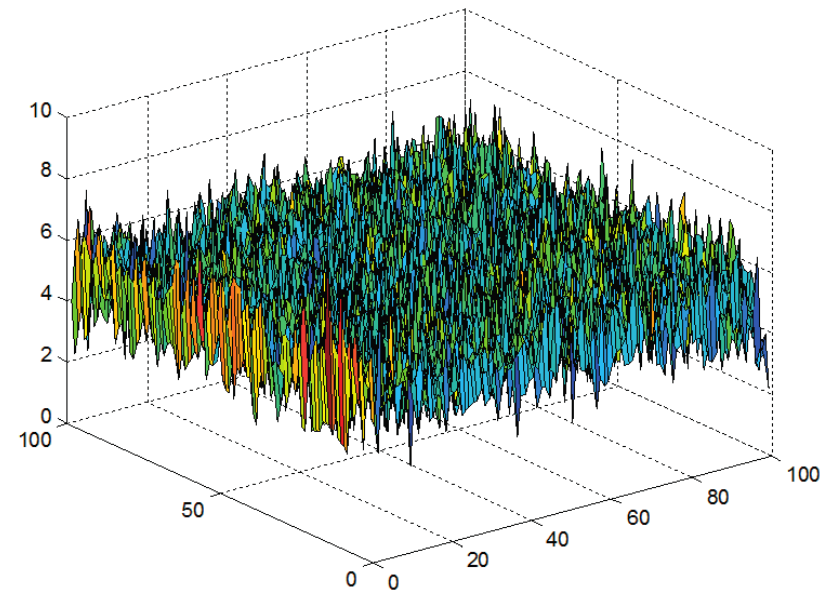
Figure 8. Node distribution under